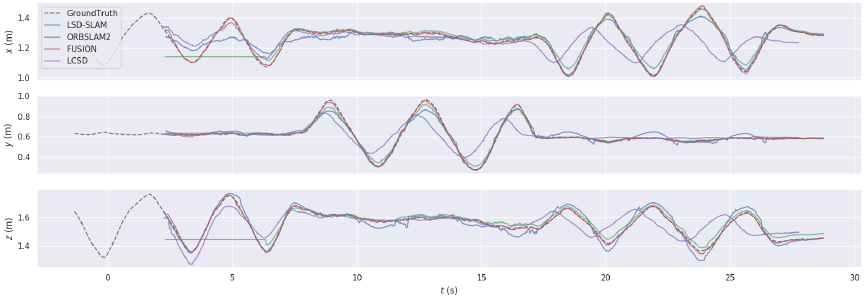
Figure 4. Trajectory comparisons between the proposed fusion system, LCSD, ORBSLAM2 and LSD-SLAM on the TUM sequence “ fr 1/ xyz ”. Table 4. Statistical data of the comparison between our proposed system, LCSD, ORBSLAM2 and